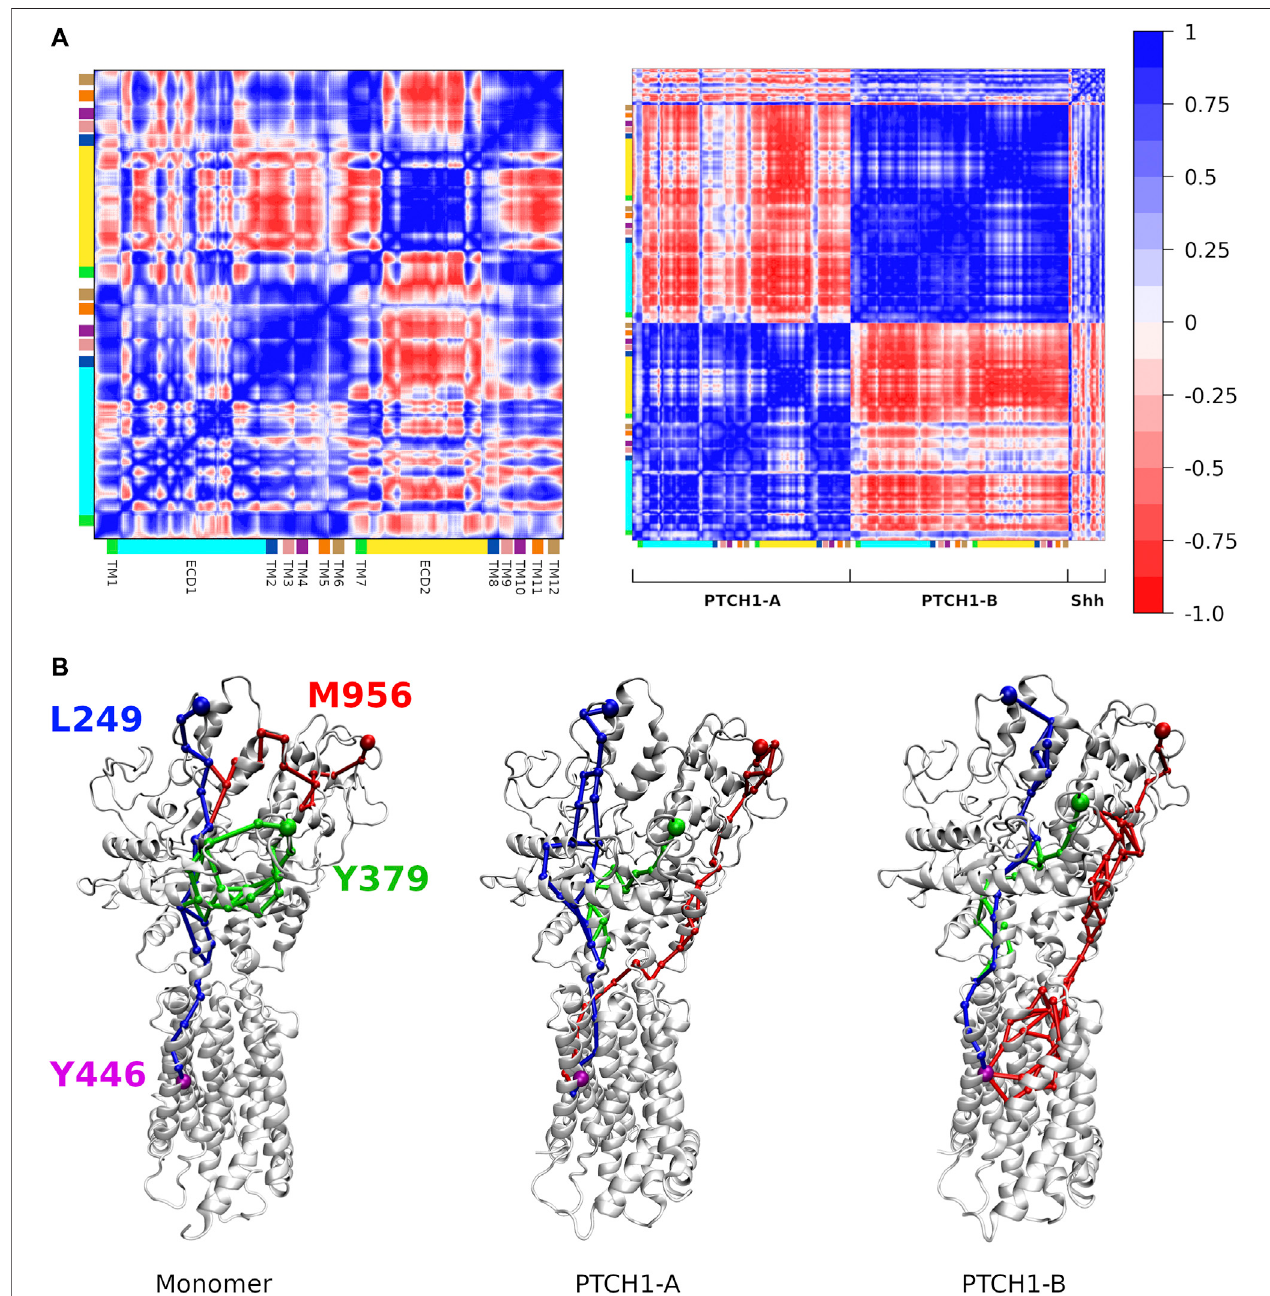
FIGURE 5 | Dynamic communications in the PTCH1. (A) Dynamical cross-correlation matrices of backbone beads of the PTCH1 monomer (left) and dimer-Shh (right) systems. (B) Allosteric communication pathways between L249/Y379/M956 and Y446, colored in blue, green and red respectively.